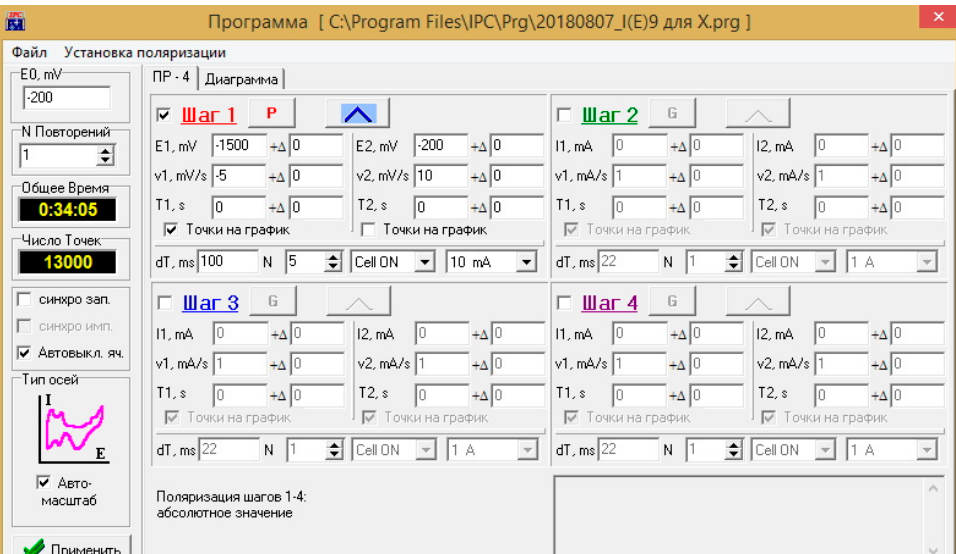
Figure 7. Program dialog box in IPC2000.